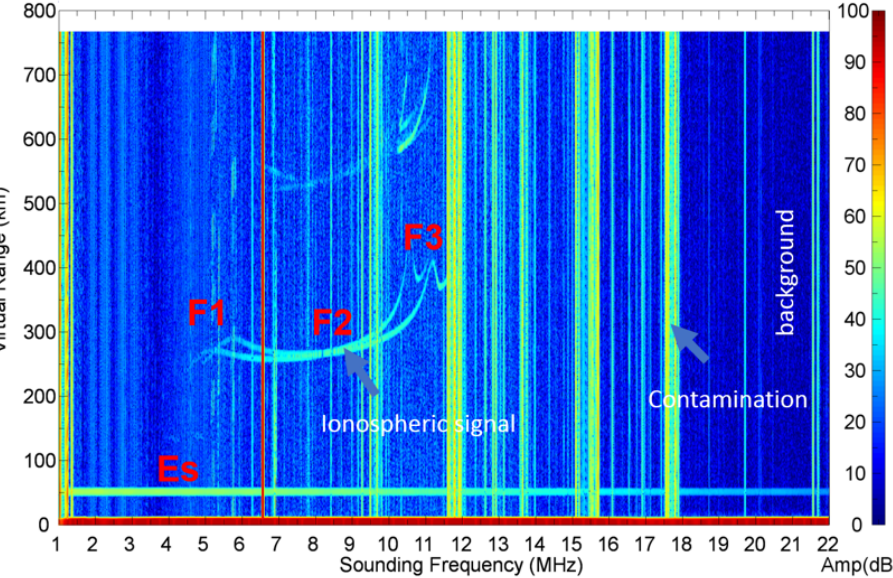
Figure 1. An ionogram containing three key features: the background, the contamination, and the ionospheric signal. The color bar on the right represents the amplitude of the signal in Decibels